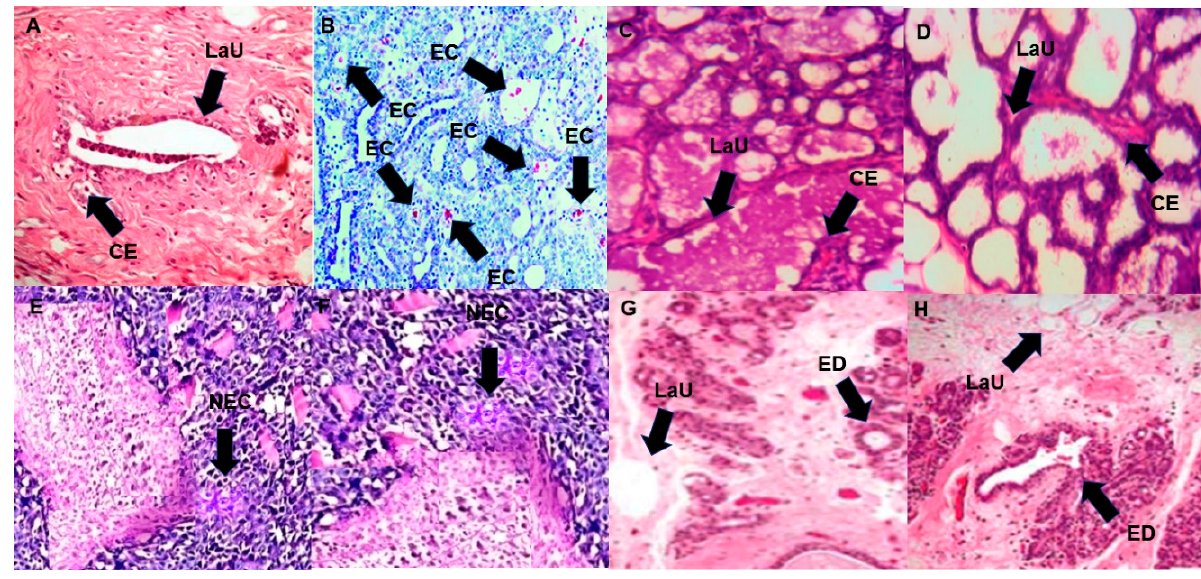
Figure 9. Photomicrograph of breast section of a normal control rat showing lobuloalveolar unit (LaU) and cuboidal epithelial cells (CE) ( A ); photomicrograph of breast section treated with MNU showing mammary gland carcinoma alongside with massive proliferation of neoplastic epithelial cells (EC) ( B ); photomicrograph of breast section treated with 3DPQ-12 in a concentration of 5 mg/kg of bwt showing lobuloalveolar unit (LaU) and cuboidal epithelial cells (CE) ( C ); photomicro- graph of breast section treated with 3DPQ-12 in concentration of 50 mg/kg of bwt showing lob- uloalveolar unit (LaU) and cuboidal epithelial cells (CE) ( D ); photomicrograph of breast section treated with 4-OHT in a concentration of 5 mg/kg of bwt showing necrosis (NEC) ( E ); photomicro- graph of breast section treated with 4-OHT in concentration of 50 mg/kg of bwt showing necrosis (NEC) ( F ); photomicrograph of breast section treated with Ral in a concentration of 5 mg/kg of bwt showing differentiated extralobular ducts (ED) ( G ); photomicrograph of breast section treated with Ral in a concentration of 50 mg/kg of bwt showing differentiated extralobular ducts (ED) ( H ), shown in x200 magnification and stained with hematoxylin and eosin. Finally, the compounds were assayed for the maximum tolerated dose (MTD) or maximum feasible dose (MFD, in the absence of MTD) and weight loss (WL) studies (Ta- ble 11). Compounds and controls were daily re-administered per os in five doses, 5, 50, 100, 500, and 1000 mg/kg bwt [160] for 5 days. On the 5th day, the body weights were measured, and the postmortem evaluations were performed by means of a gross exami- nation of all the animals at the terminal necropsy, as well as the histopathological exami- nation of lungs, spleen, liver, kidneys, heart, and colon (Supplementary Materials Figures S219–S224, respectively). Hence, except for MNU , with an MTT of 100 mg/kg bwt, no mortality was observed in the treatment groups for 5 days even at the highest dose (Table 11). The orally administered compounds 3DPQ-12 , 3DPQ-3 , 3DPQ-9 , 3DPQ-4 , 3DPQ-2 , and 3DPQ-1 did not produce significant changes in body weight. Moreover, no obvious pathologic changes were observed based on histology or necropsy compared to placebo- treated controls. Therefore, given that the Food and Drug Administration (FDA) recom- mends 1000 mg/kg bwt as the high limit dose for acute, subchronic, and chronic toxicity studies in rodents and non-rodents [160], MTDs were not explicitly determined, and the 1000 mg/kg bwt could be considered as MFD (https://www.fda.gov/drugs/guidance-com- pliance-regulatory-information/guidances-drugs, accessed on 1 March 2022) for 3DPQ- 12 , 3DPQ-3 , 3DPQ-9 , 3DPQ-4 , 3DPQ-2 , and 3DPQ-1 [160]. All the compounds were proven safe for further pre-clinical and clinical trials at a concentration of 50 mg/kg bwt.